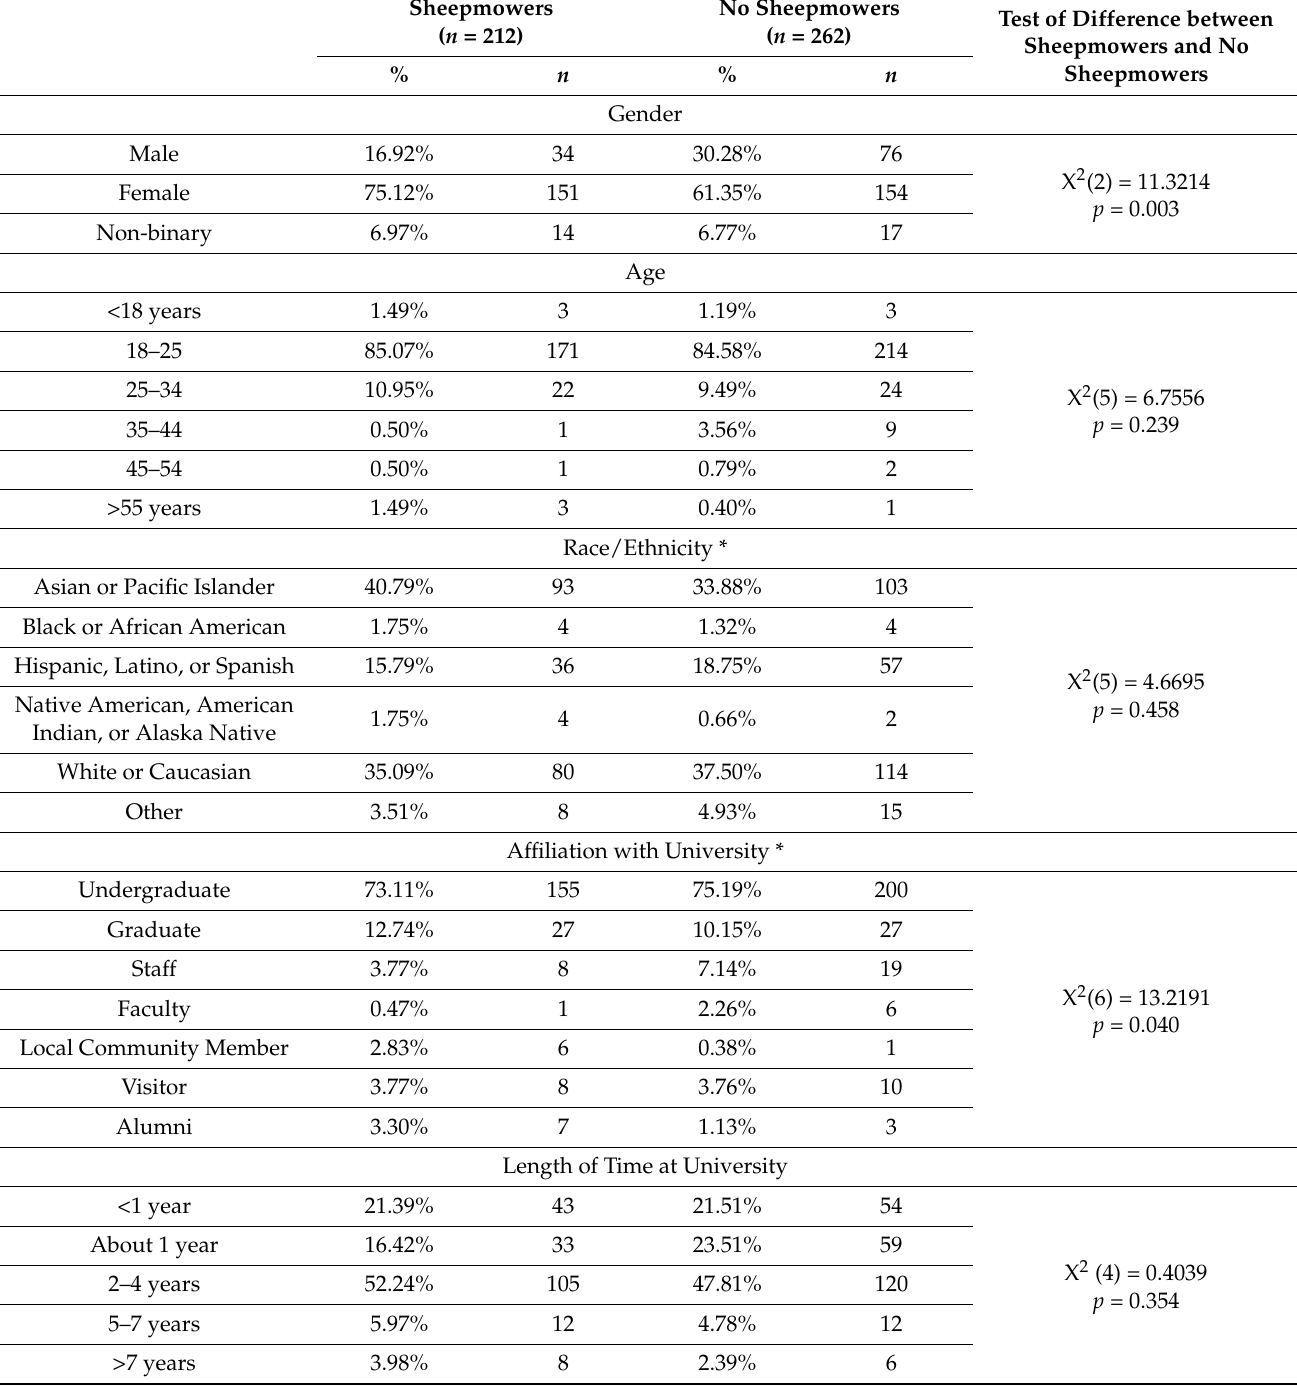
Table 2. Demographic Characteristics of Web-based Survey